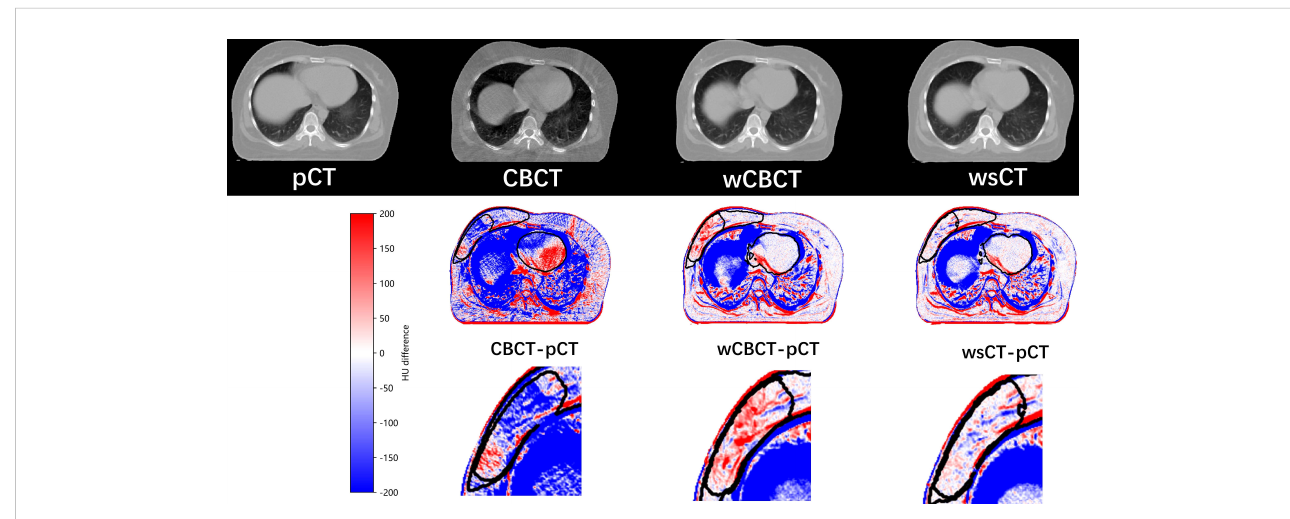
FIGURE 5 The pCT, CBCT, warped CBCT, and warped sCT images displayed in the same window for a single patient, and the second row shows the difference between CBCT, warped CBCT, and warped sCT images and pCT images.